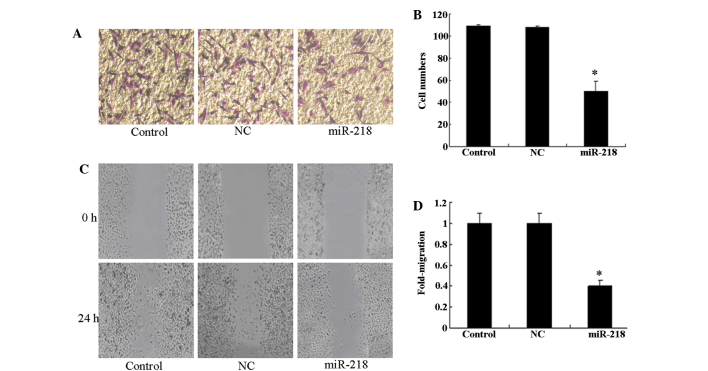
miR-218 suppresses U87 cell invasion. (A and B) U87 cells were examined for cell invasion in 24-well plates with Transwell chambers. The migrated cells were stained with crystal violet. The invasiveness of U87 cells was attenuated with the upregulation of miR-218. (C and D) Images of the scratch-wound healing assay were captured at 0 and 24 h, and the wound gaps were analyzed by measuring the distance of migrating cells for three regions of each wound. *P<0. 05. NC, negative control; miR-218, microRNA 218.